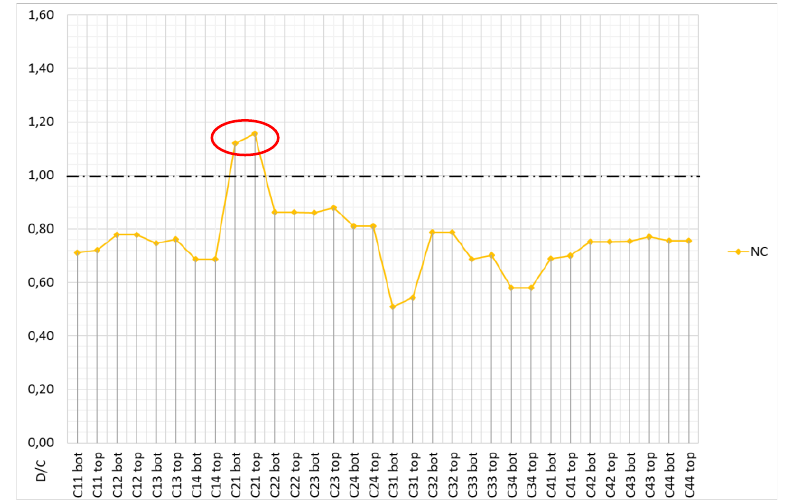
Figure 15. FINAL: NC chord rotation D / C ratios on columns (pushover analysis).